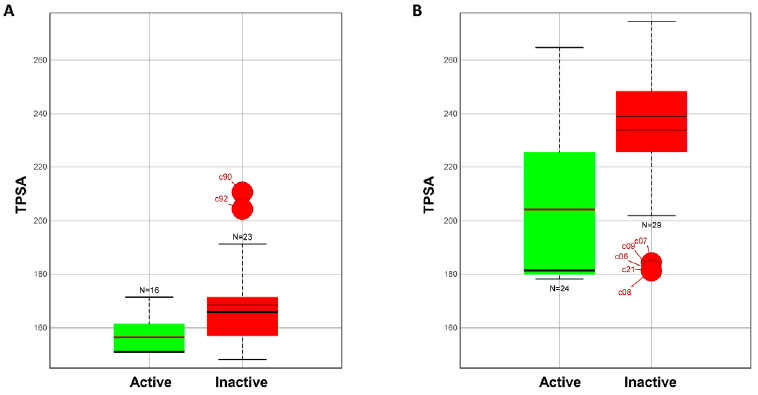
Figure 7. TPSA (polarity) distribution: ( A ) CRBN subclass. ( B ) VHL subclass.